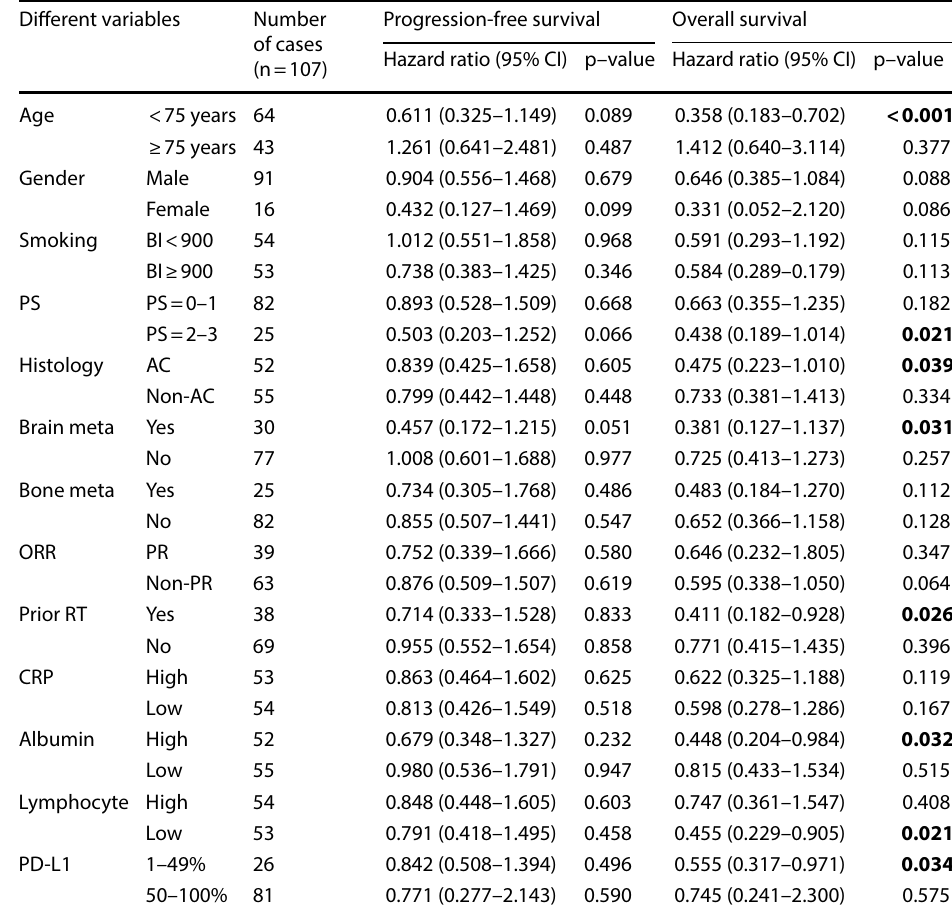
Table 4 Survival analysis of subgroups according to intratumoral CD8